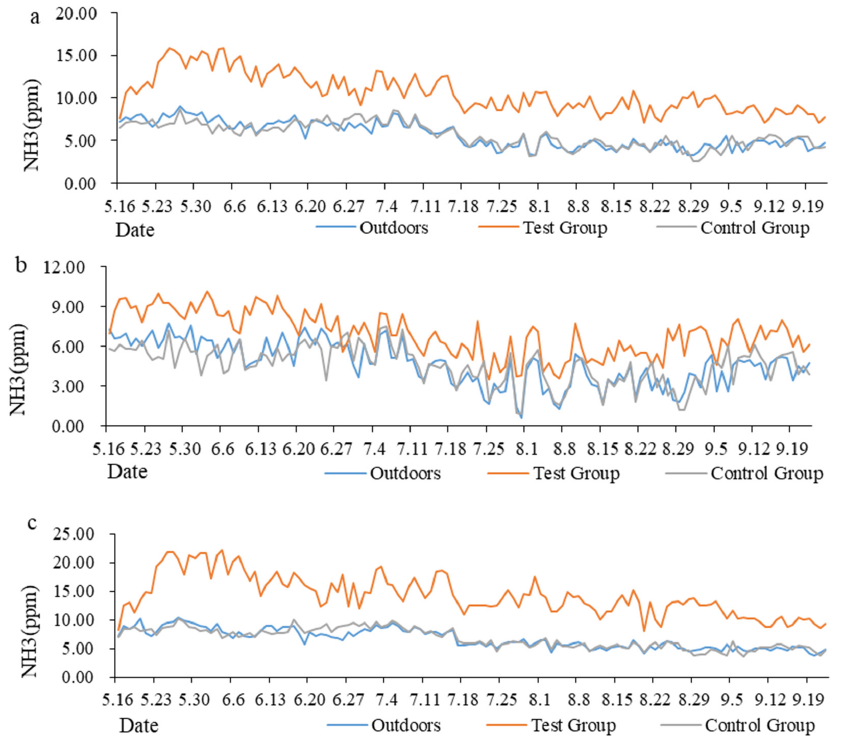
Figure 4. The variation trends in NH 3 concentration throughout the experimental period. ( a ) The